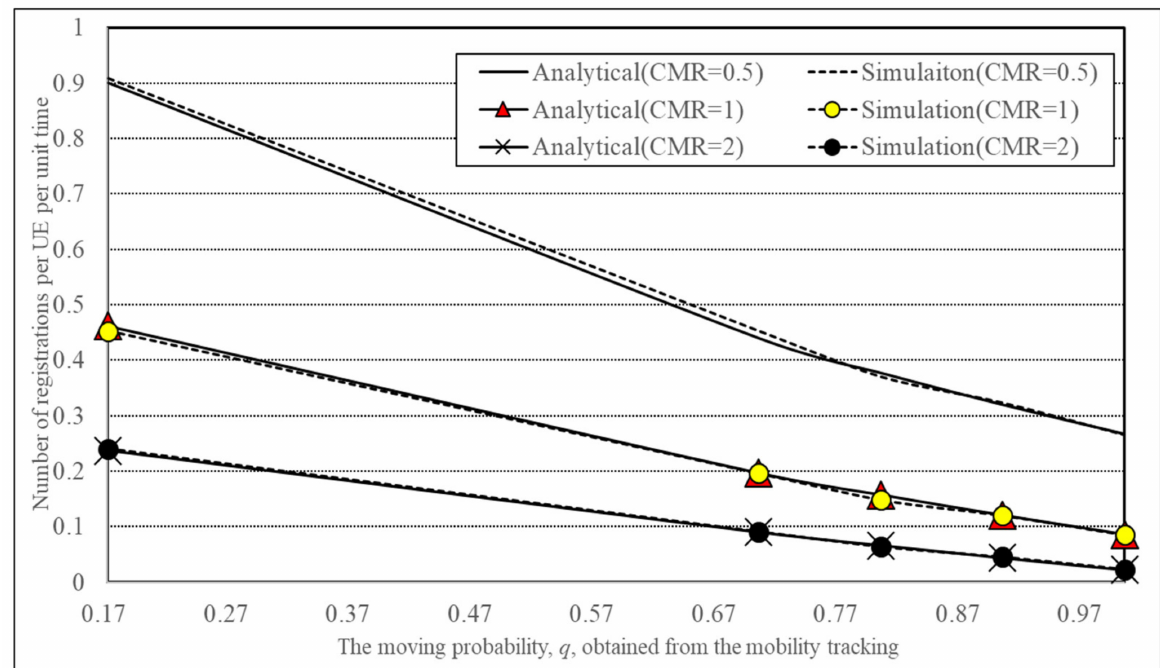
Figure 5. Number of registrations versus call-to-mobility ratio